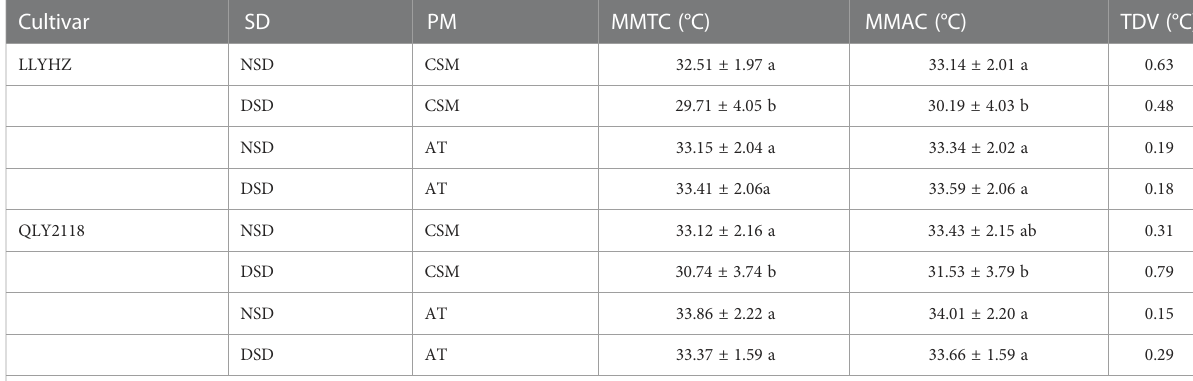
TABLE 1 Leaf area index, average maximum canopy temperature, and temperature difference between treatments at the heading stage of two rice cultivars.